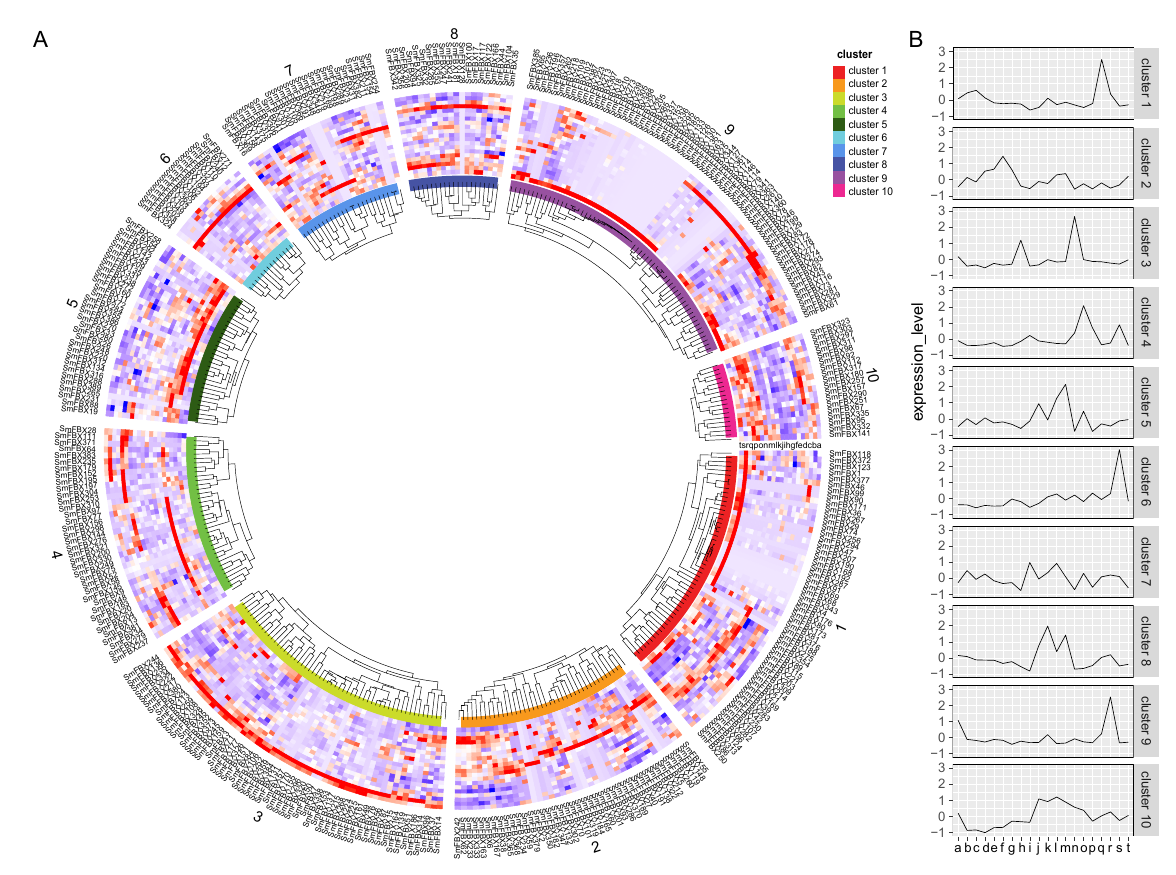
Figure 2. Transcriptome analysis of the F-box candidate gene superfamily in each tissue site of eggplant. ( A ) The expression in 20 eggplant tissues was measured and is represented by 20 letters (a–t) in cluster 1, which represents the roots (a), roots inoculated with Verticillium dahliae at 6 hpi (hours post-inoculation) (b), flowers (c), pistils (d), radicles (e), leaves (f), cotyledons (g), fruit stage 1 (h), fruit 1 cm (i), fruit 6 cm (j), fruit flesh stage 2 (k), stems (l), fruits skin stage 2 (m), fruit calyx stage 2 (n), senescent leaves (o), fruit peduncle (p), fruit skin stage 3 (q), fruit flesh stage 3 (r), buds 0.7 cm (s), and opened buds (t). Differently colored blocks represent different clusters. ( B ) The F-box was divided into 10 clusters, and the model for expression was obtained after counting the expression patterns of the F-box candidate genes in each